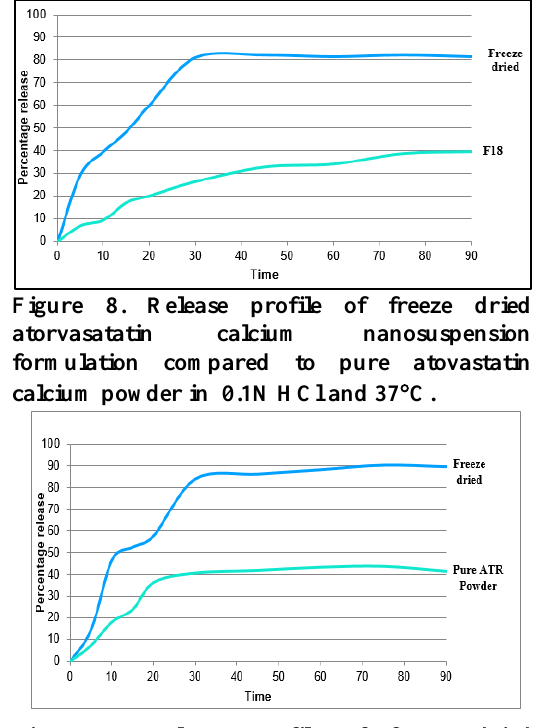
Figure 9. Release profile of freeze dried atorvastatin calcium